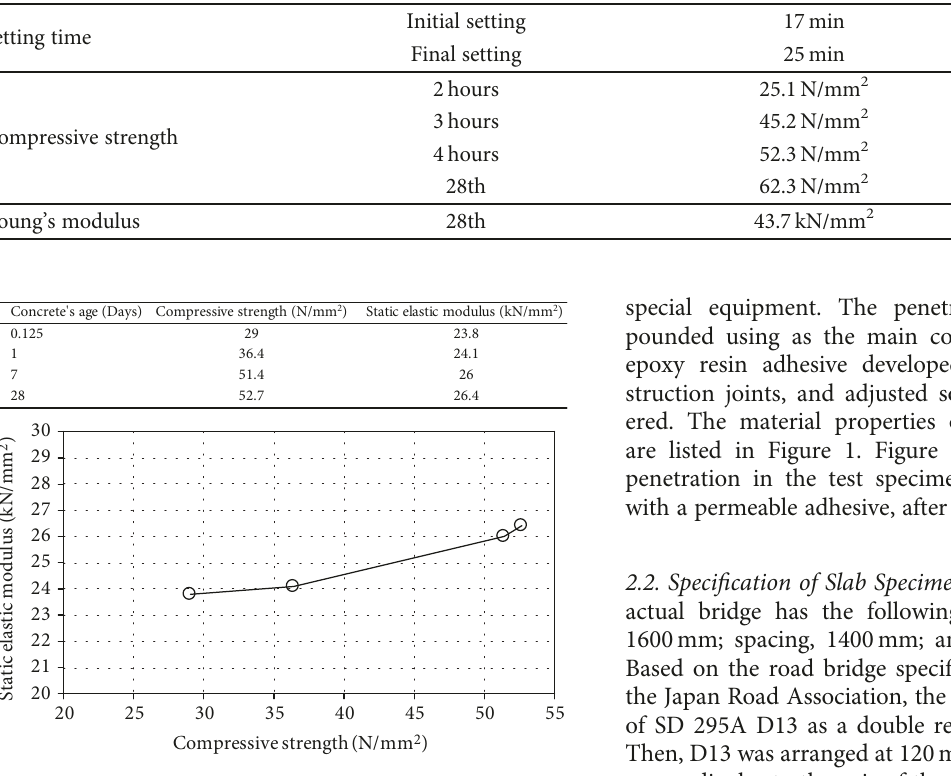
Figure 1: Relationship between compressive strength and static elastic modulus.